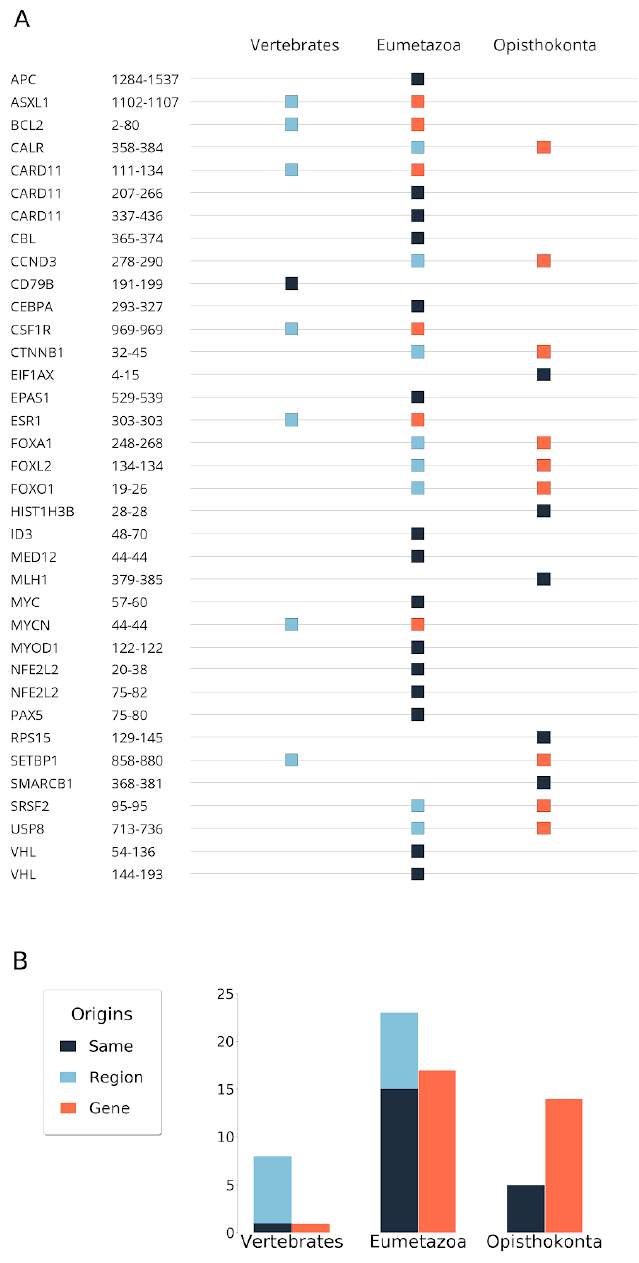
Figure 1. Conservation-based evolutionary origin of disordered cancer regions and genes. ( A ) The orange and sky blue squares represent the origin of genes and regions, respectively. Gunmetal squares indicate the same evolutionary origin at both region and gene levels. ( B ) Summary barchart of origins in the three gene-age categories.